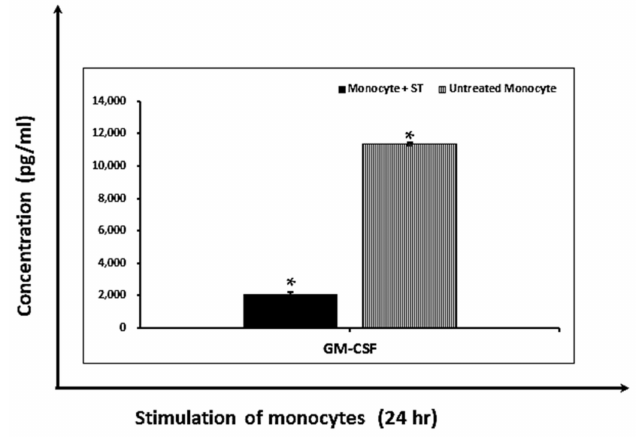
Figure 8. ST285 increases anti-inflammatory cytokine production by human monocytes. Human monocytes ( n = 3) were stimulated with ST285 for 24 h and secretion of GMCSF was measured. The treated human monocytes ( n = 3) with ST285 probiotic bacteria are referred to as monocyte + ST and human monocytes ( n = 3) cultured in media without any ST285 probiotic bacteria are referred to as untreated monocytes. The means of two different readings of three replicate experiments were measured and analyzed. The means of readings for n = 3 monocytes were calculated and presented as plus or minus ( ± ) the standard error of the mean. The symbols represent the p -value for Tukey’s test (one-way ANOVA) where * p < 0.05.